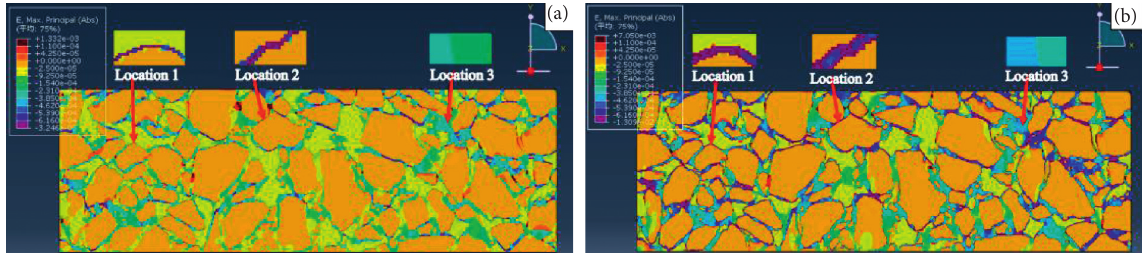
Figure 9: Strain distribution diagram of internal structure: (a) with interface; (b) without interface.